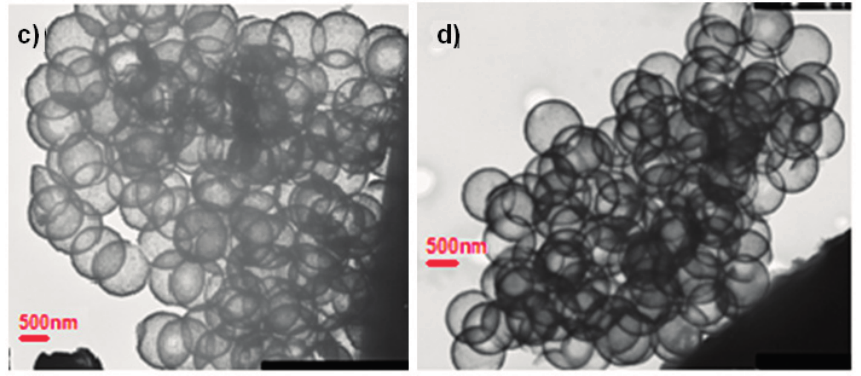
Figure 9. TEM of ( a , b ) Non-drug loaded, PCL based nanocapsules and ( c , d ) CPZ-loaded PCL based nanocapsules (Magnification 50,000× ( a and b ); 40,000× ( c and d